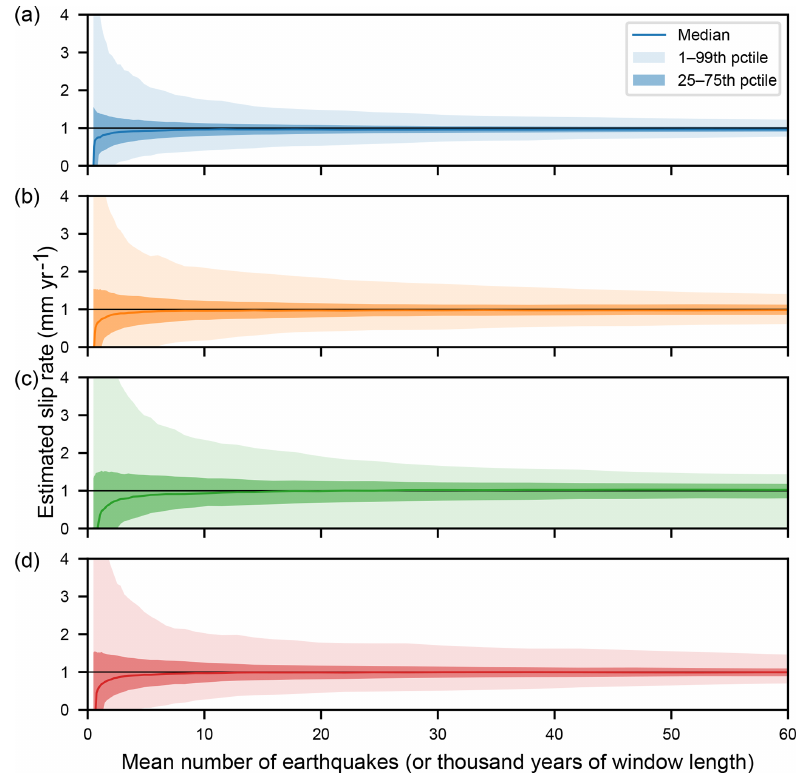
Figure 5. Envelopes of estimated slip rates as a function of the mean number of earthquakes (or thousands of years) over which the slip rate was estimated. All slip rates have a true value of 1mmyear − 1 . (a) periodic distribution; (b) unclustered lognormal distribution; (c) clustered lognormal distribution; (d) unclustered exponential